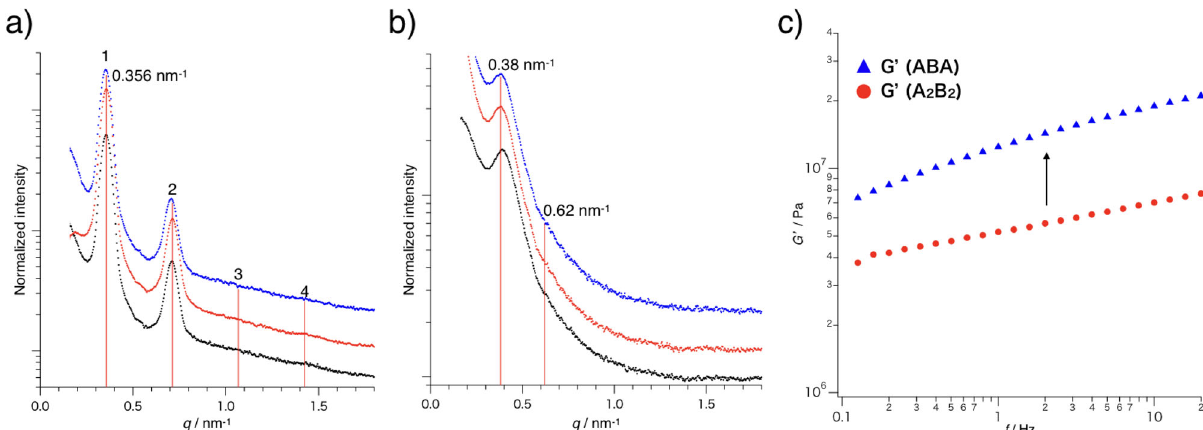
Fig. 6 SAXS pro fi les and shear rheology pro fi les of before and after topology transformation. SAXS pro fi les ( a ) before ( A 2 B 2 ) and ( b ) after ( ABA ) the topology transformation (annealing conditions: black — no annealing; red — 100 °C, 12 h; blue — 120 °C, 12 h). c Shear rheology pro fi les (G ′ ) at 303 K before ( ● A 2 B 2 ) and after ( ▲ ABA ) the topology